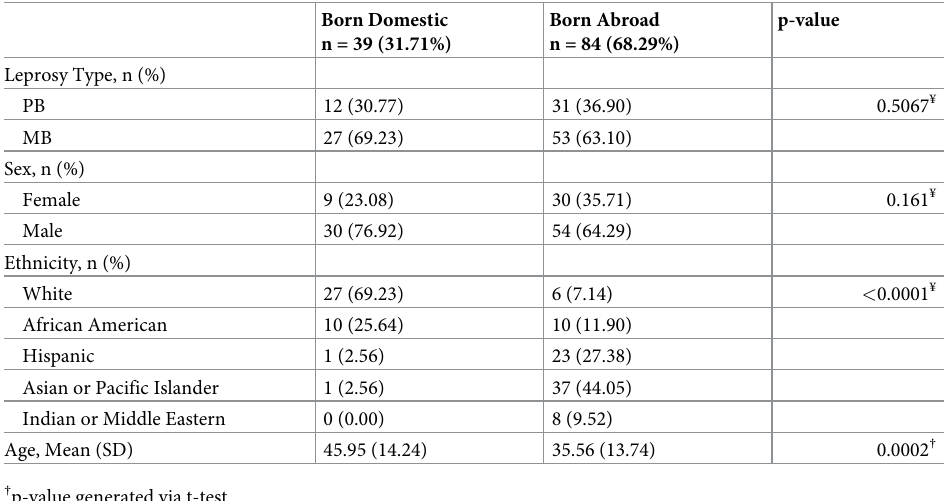
Table 1. Demographic characteristics of the 123 cases of leprosy in Georgia included in the study, divided by place of birth and evaluated by chi-square or t-test where appropriate. Born Domestic Born Abroad n = 39 (31.71%) n = 84